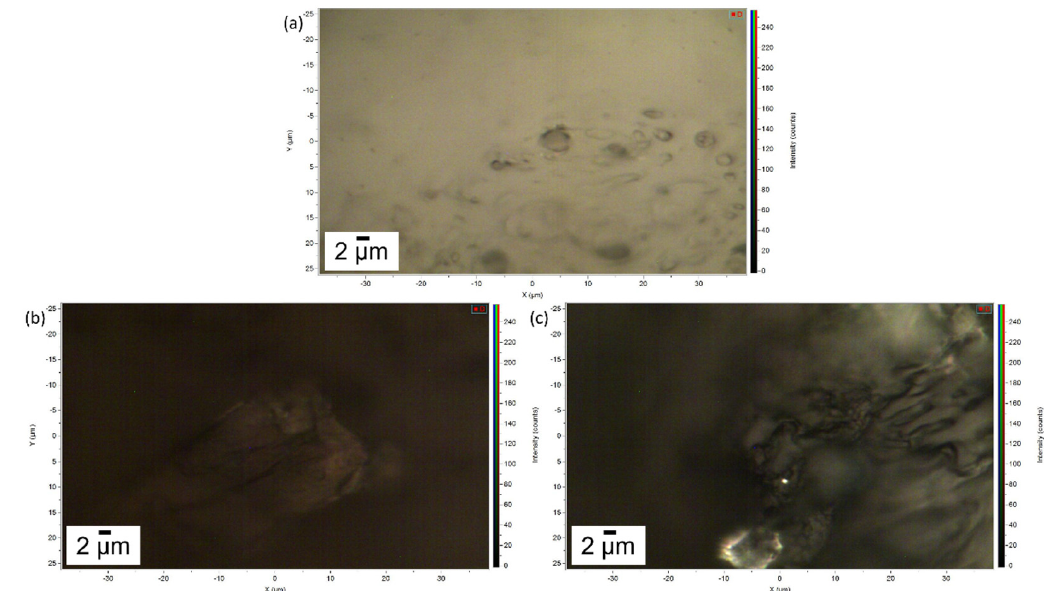
Figure 4. Image of ( a ) the pure gel, ( b ) the gel used to remove penny corrosion products from Travertine and ( c ) the gel used to clean Carrara marble from euro cents corrosion products. The scale bar is 2 µm and the image magnification is 100×.